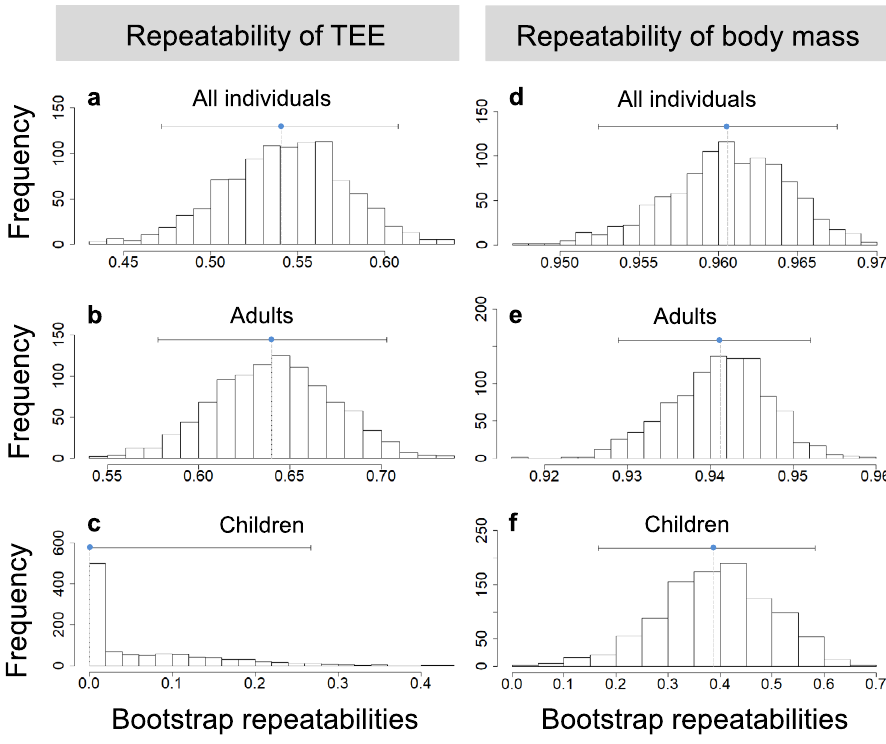
Fig. 1 Repeatability estimates of total energy expenditure (TEE) and body mass. Repeatability estimates of a – c TEE and d – f body mass at the individual level. Shown are distributions of the parametric bootstrap samples along with the point estimate of the repeatability estimate R (blue point) and the limits of the con fi dence interval (gray lines). a , d show all individuals together ( N = 395 subjects), b , e show adults ( N = 348 subjects) and c , f show children ( N = 47 subjects) separately. Table 1 Phenotypic ( r p ), among-individual ( r ind ), and within-individual ( r e ) correlations between unadjusted TEE and FM (Models 1 + 3) and unadjusted TEE and body fat percentage (Models 2 + 4).